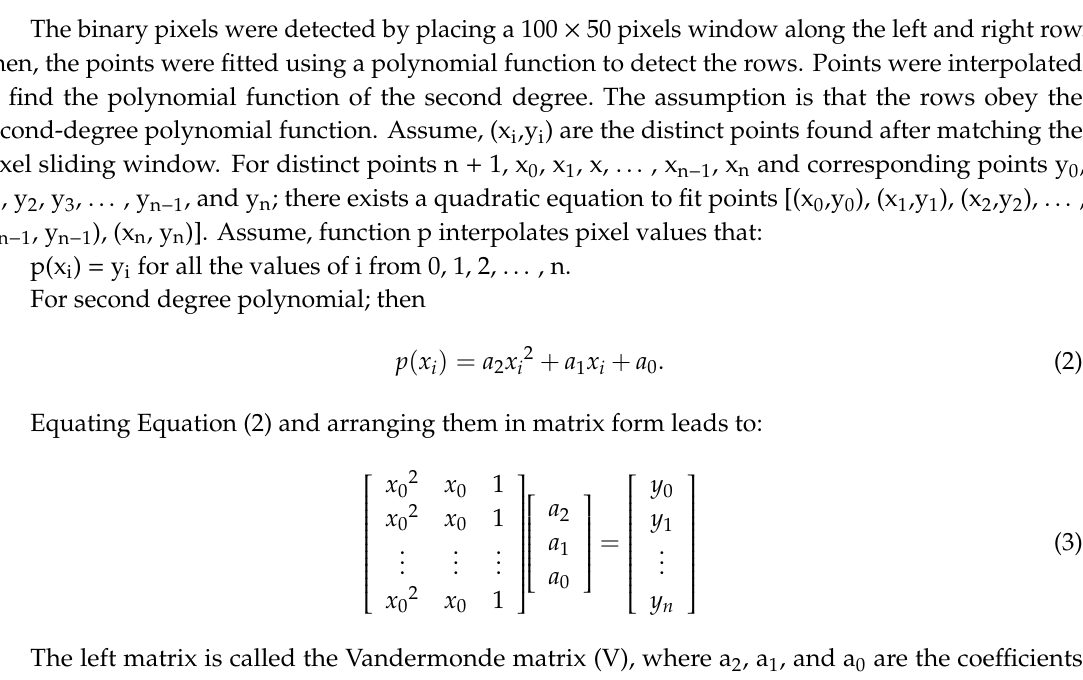
3 Figure 7. Sliding window comparison with the polynomial fit using Manhattan distance. The upper image ( 1 ) was successful detection; center image detection ( 2 ) was moderate detection; and the lower image ( 3 ) indicated no row detection. 2.3. Boll Detection and Location Estimation Each image frame was acquired using a ZED camera and analyzed using a 4-step machine vision algorithm (Step 1, depth processing; Step 2, color segmentation; Step 3, feature extraction; and Step 4, frame matching for position determination). These steps were handled by the graphic card optimized rugged development kit (NVIDIA Jetson TX2) to achieve improved matrices calculations using the NVIDIA CUDA cores. Depth processing was achieved by using the ZED stereo camera, which had two lenses with a separate 1/3” 4MP CMOS image sensor for each lens. This arrangement allowed the camera to have the ability to process three-dimensional (3D) images that provided the depth measurement of a cotton boll to the camera. The proximity to the cotton bolls was used to determine the distance from the